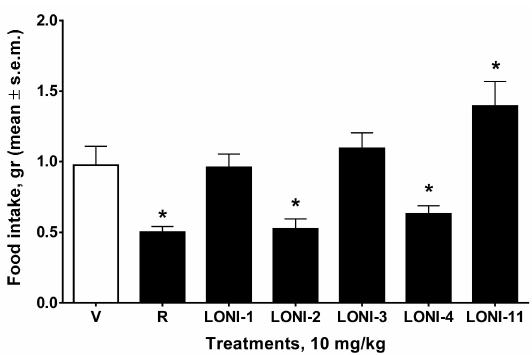
Figure 3. Activities of rimonabant, LONI1-4, LONI11 and vehicle (V, 1:1:18 mix of DMSO: Tween